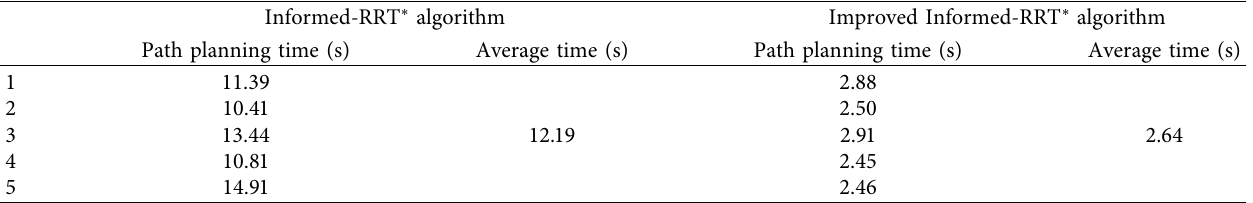
Table 2: Experimental results of the time consumption of path planning in raster maps with and without the improved-RRT ∗ algorithm. Informed-RRT ∗ algorithm